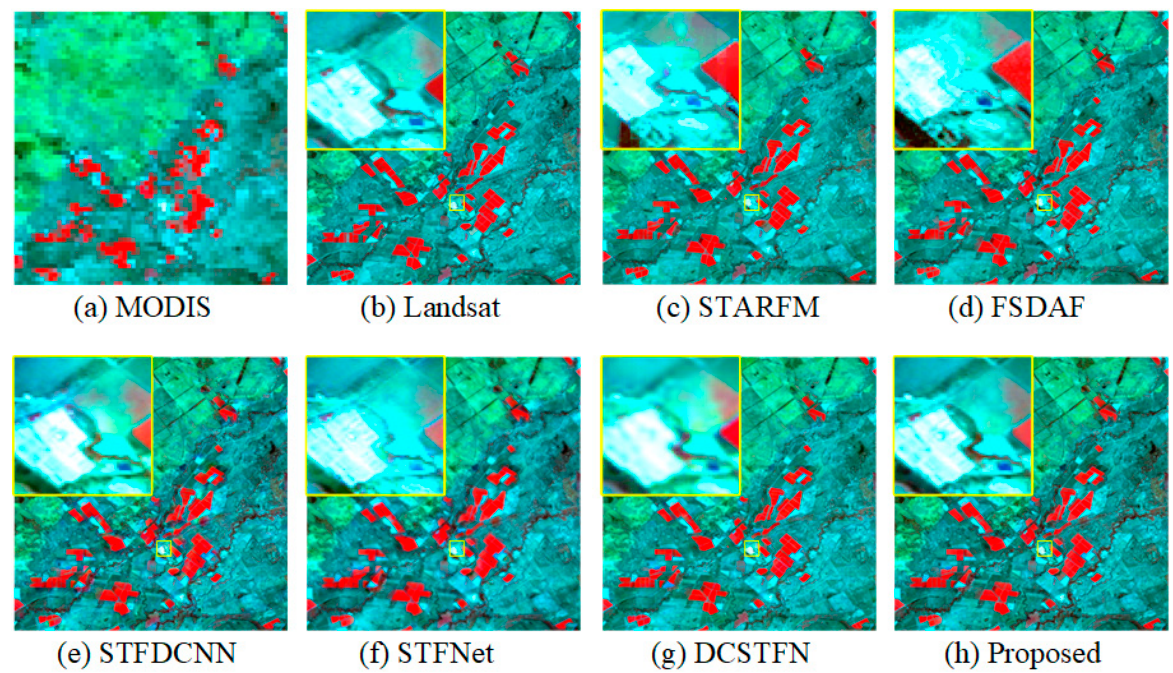
Figure 6. Prediction results of Landsat satellite images (2 March 2005) in LGC dataset. ( a ) is the corresponding MODIS image, ( b ) is the real image, ( c – g ) are the prediction results of STARFM, FSDAF, STFDCNN, StfNet, and DCSTFN models, respectively, and ( h ) is the prediction result of our model.